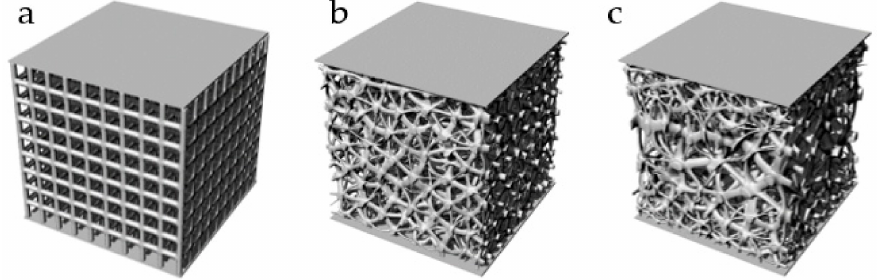
Figure 27. Designed models: ( a ) Regular porous structure; ( b ) Irregular porous structure; ( c ) Gradient irregular porous structure.